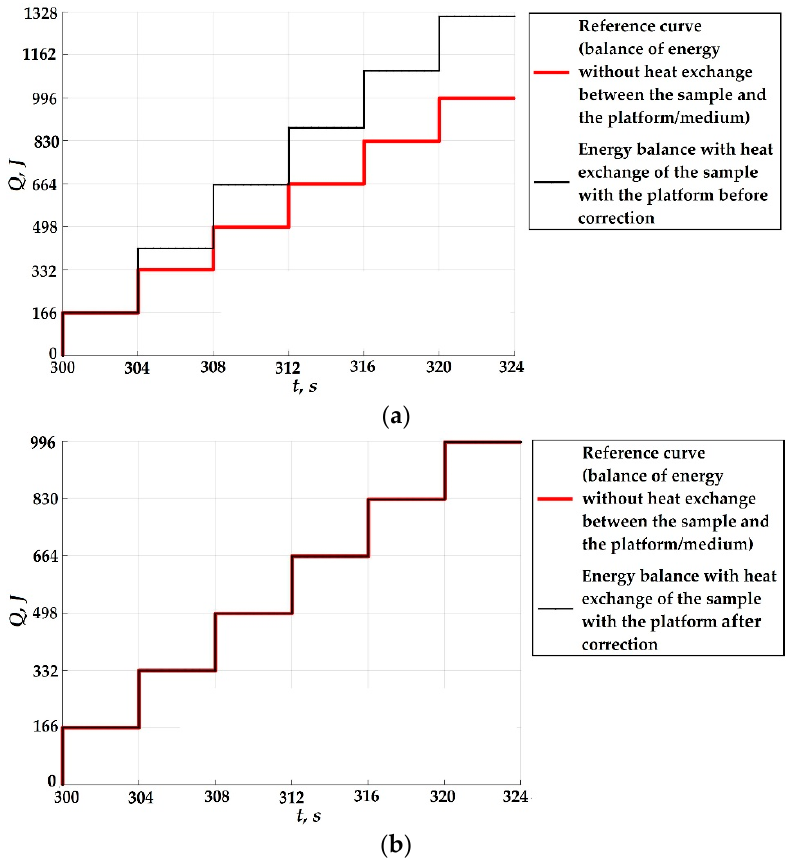
Figure 19. Energy balance for solutions with varying degrees of discretization of the problem with- out taking into account the heat transfer of the sample with the platform and the surrounding me- dium: ( a ) throughout the entire deposition process; ( b ) during the formation of the first layer. Three hundred seconds is the waiting time for the thermal state of the platform to reach the stationary mode.